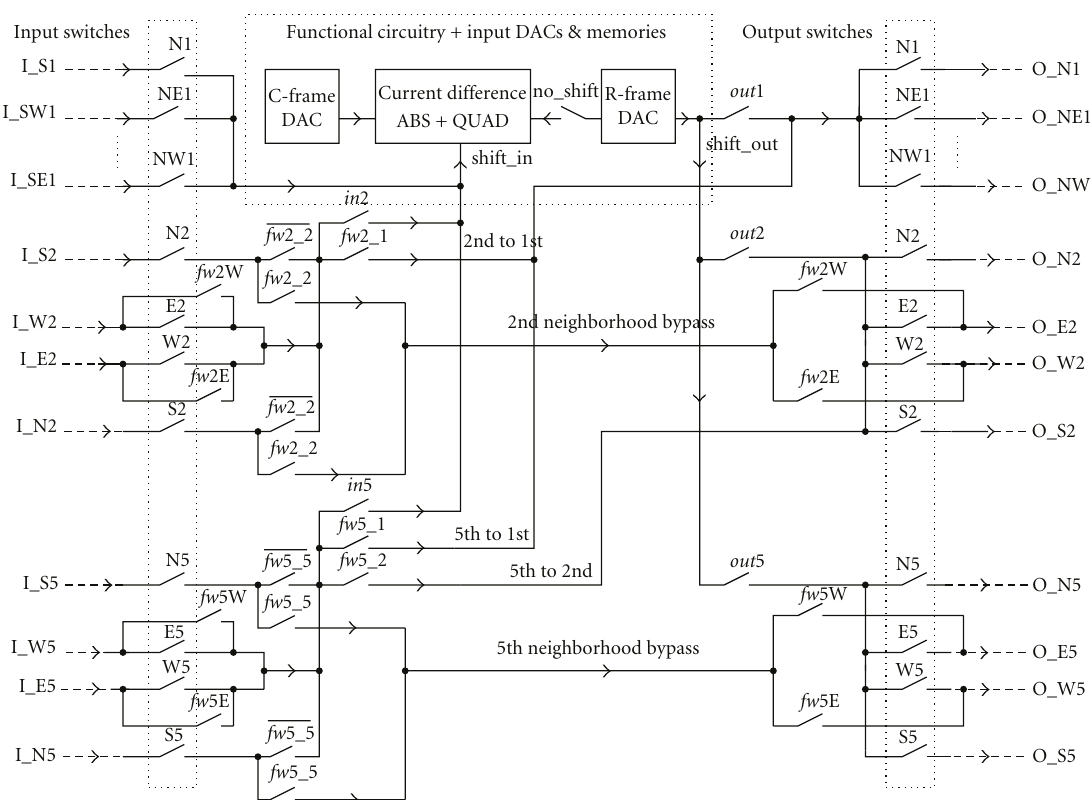
Figure 4: Cell switch configuration for the reference shift. All switches are implemented with NMOS